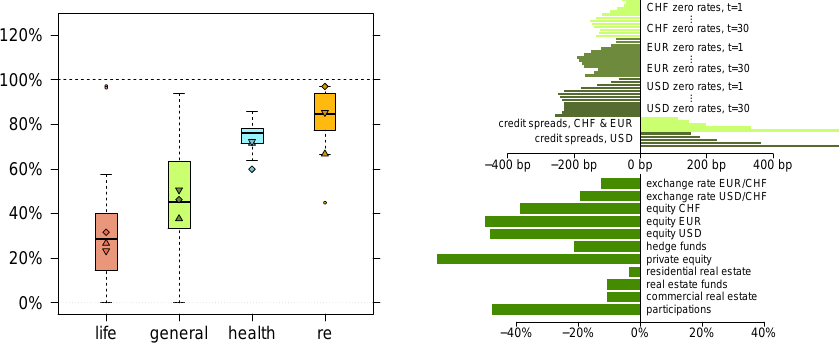
Figure 8. (rhs) illustrates the changes in market risk factors corresponding to the financial crisis of 2007/2008, see FINMA [37]. (lhs) illustrates the resulting impact ratios (cid:36) i of the insurance companies, where (cid:78) , (cid:7) and (cid:72) correspond to the impact ratios of the first, second and third largest company, respectively, in each branch of